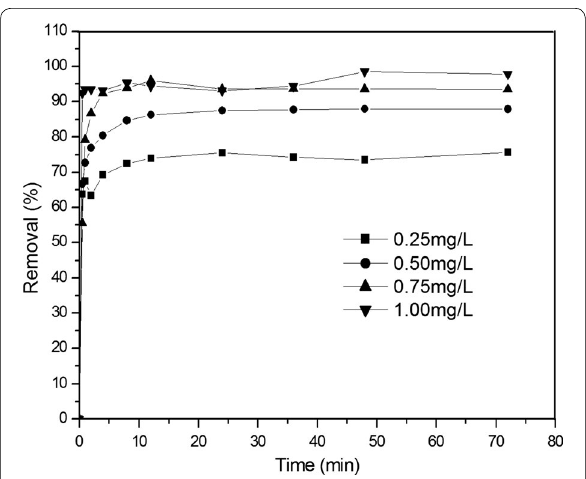
Fig. 1 The removal efficiency for As with the activated sludge system